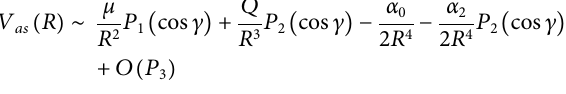
FIGURE 2 | Contour plot of rigid-rotor PES of HCN + (1 2 Σ + / 1 2 A ′ ) as a function of R and γ with r fi xed at r eq (cid:1) 2.23 a 0 . The spacing between the contours is 0.2 eV.